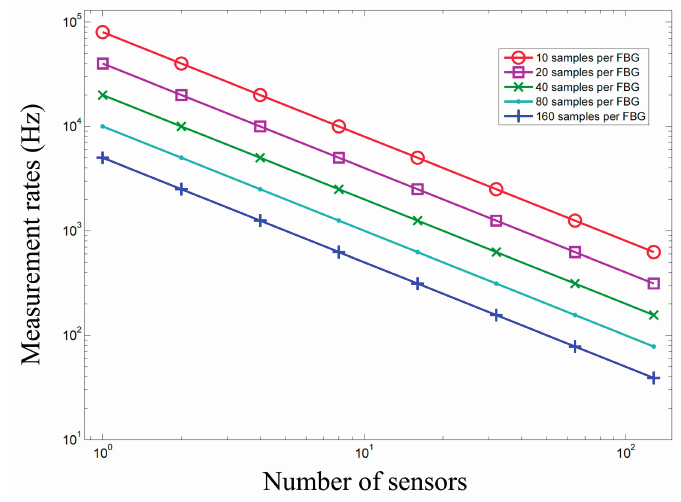
Figure 6. The measurement rates according to the number of sensors with different samples per FBG, measuring the FBG reflected waveforms.